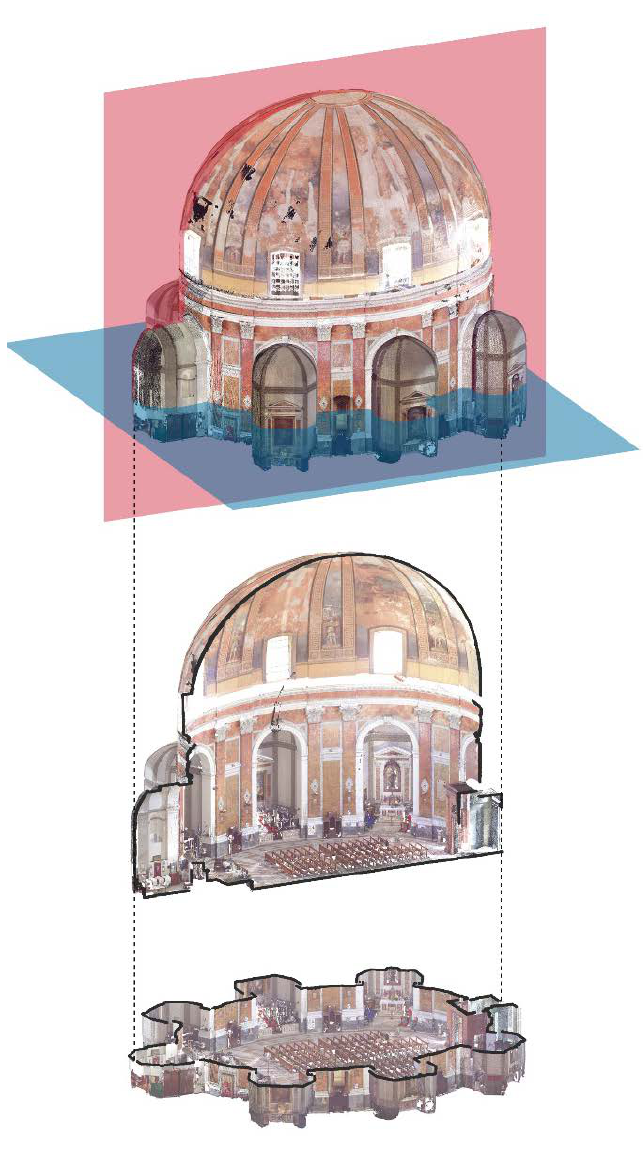
Figure 2. Point cloud: 3D section and